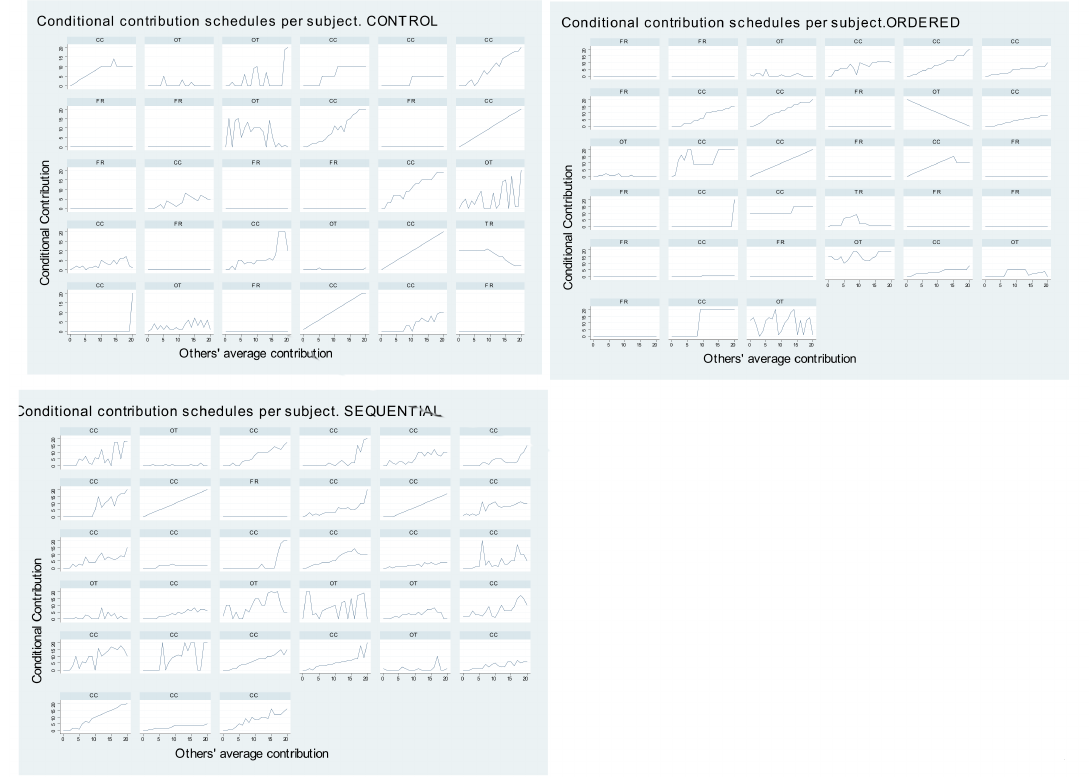
Figure A3. Individual contribution schedules. The letters on top of each subgraph indicate how that particular individual was classified (CC: conditional cooperator; FR: free rider; TR: triangle; OT: